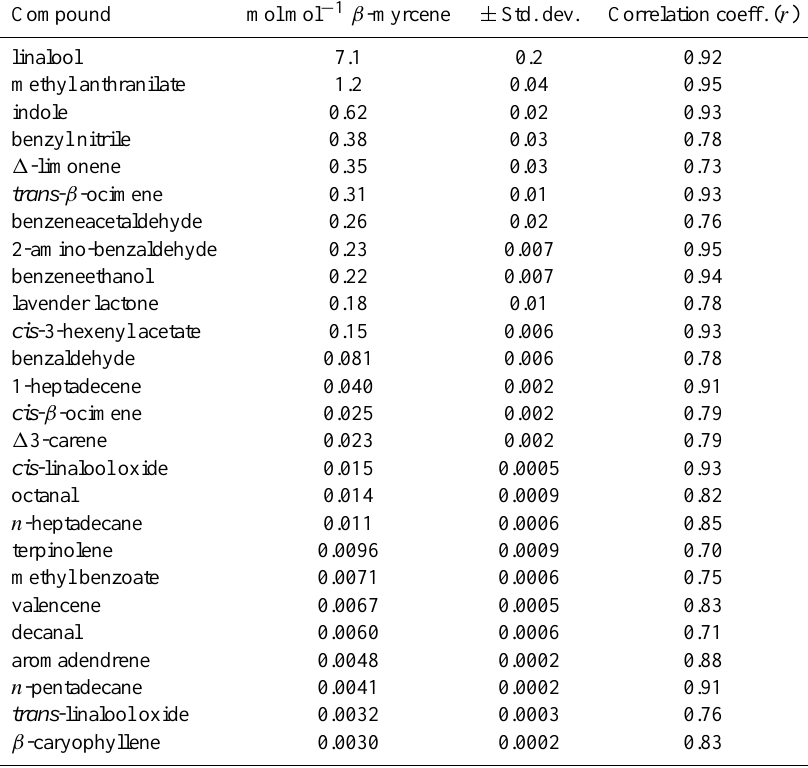
Table 5. Compounds well-correlated with flowering emissions (represented by β -myrcene).